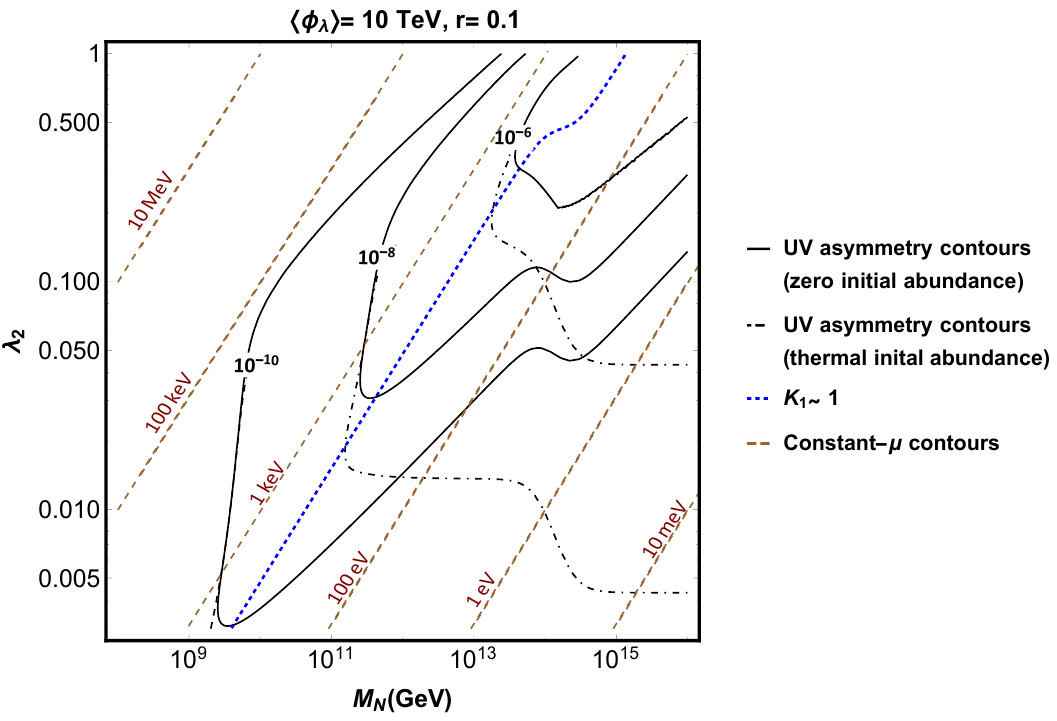
Figure 4 . Contours of UV asymmetry and (cid:22) generated in the high scale module in the ( M N ; (cid:21) 2 ) plane for (cid:8) (cid:21) = 10 TeV and r = 0 : 1. Solid curves are contours of UV asymmetry assuming zero h i initial abundance of N and dot-dashed curves are contours of UV asymmetry with the assumption of thermal initial abundance for N . The brown dashed lines are contours of constant (cid:22) . The blue dotted line sets the boundary between strong washout regime (to the left of the line) and weak washout regime (to the right of the line) for the high scale